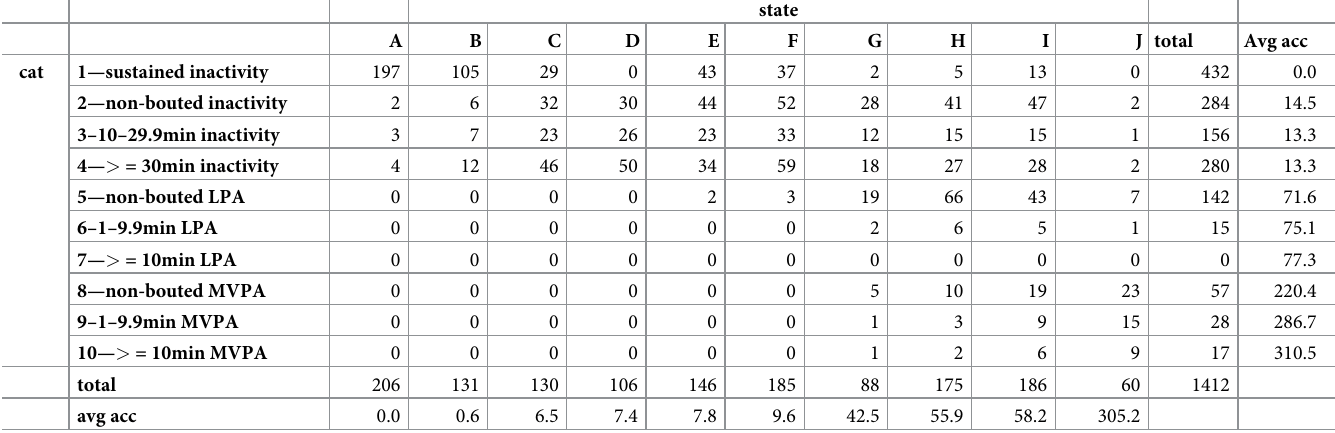
Table 2. Average time spent (minutes) per participant per day in each state from the acceleration+angle method and cut-points category. The states are sorted on mean acceleration, resulting in higher numbers around the diagonal.